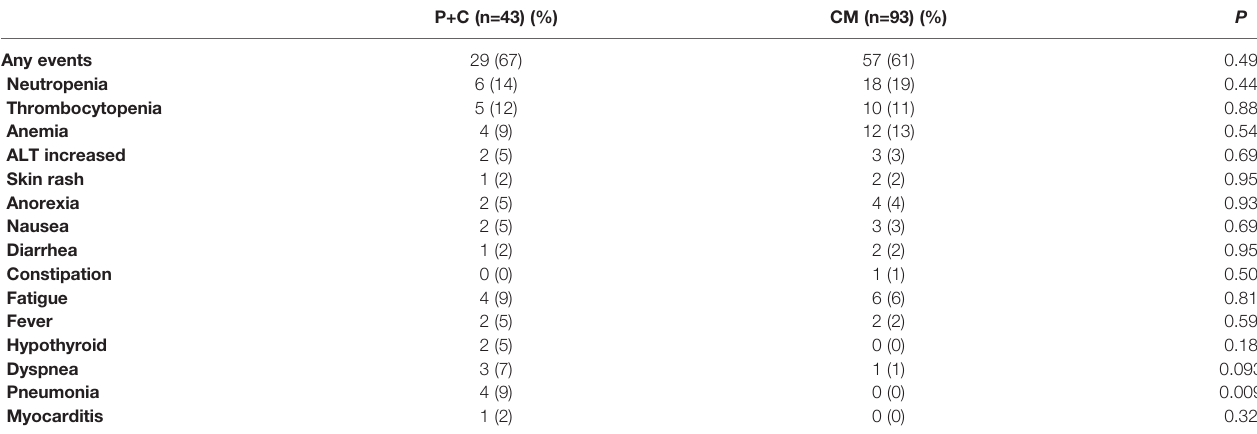
TABLE 3B | Grade ≥ 3 adverse events in different treatment groups.